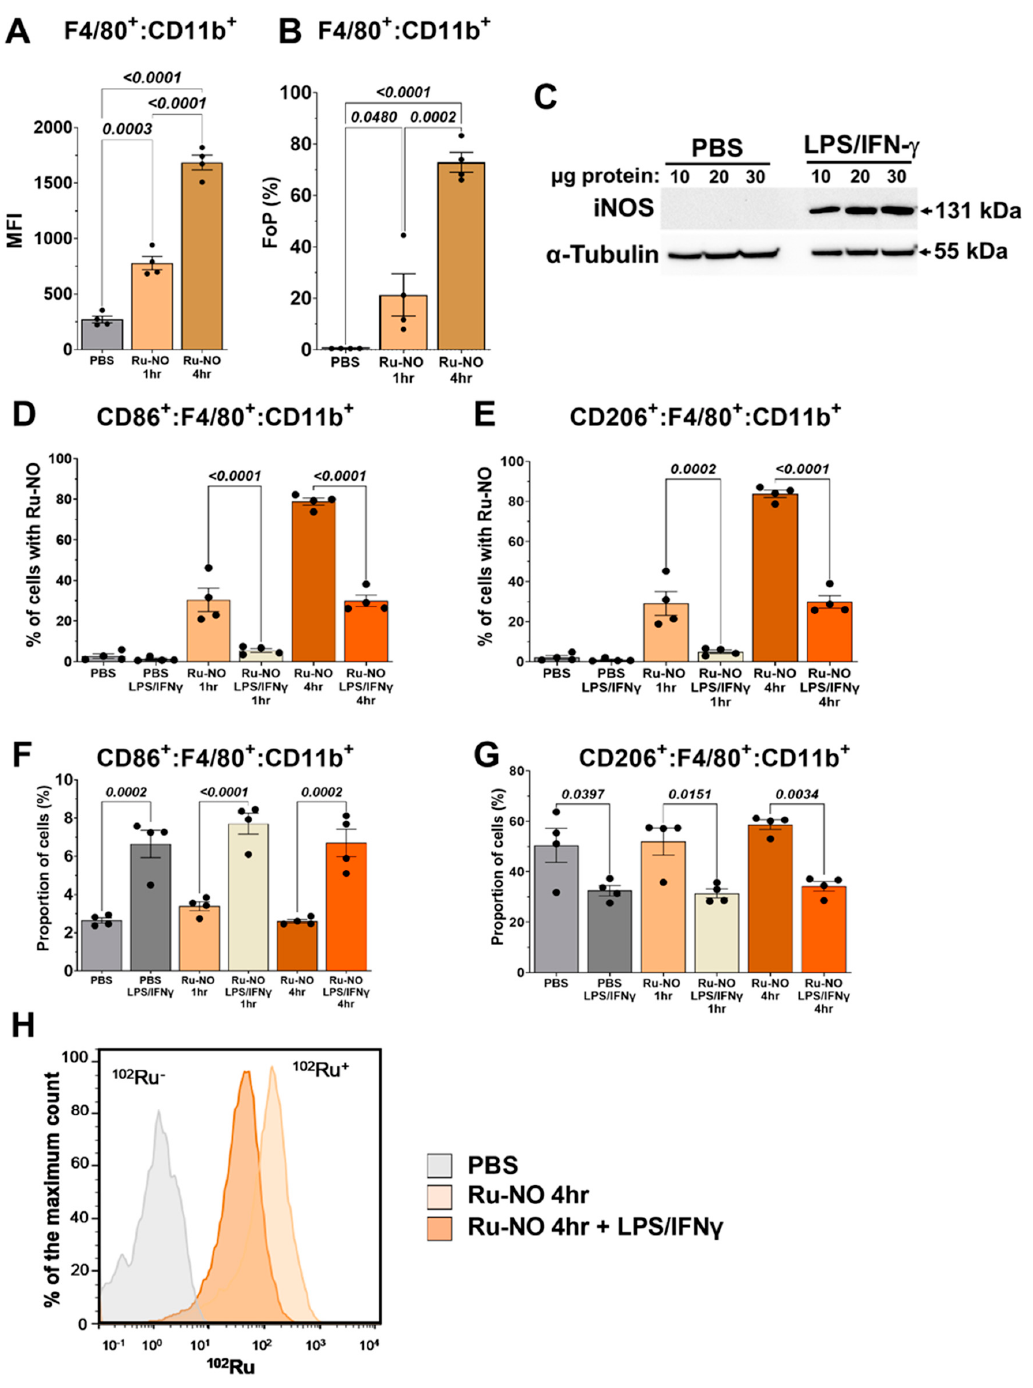
Figure 2. Ru-NO sensor uptake and detection in murine M1- and M2-like macrophages. Mouse bone marrow derived macrophages (BMDMs) were assessed for Ru-NO uptake using flowcytometry. ( A ) Mean Fluorescence Intensity (MFI) and ( B ) Frequency of Parental (FoP) of PBS and Ru-NO ex- posed CD11b + F4/80 + BMDMs in the absence of inflammation/polarisation. ( C ) Western Blot analysis of iNOS expression in BMDMs with/without LPS + IFN- γ stimulation. The percentage of cells with Ru-NO uptake in ( D ) M1-like and ( E ) M2-like macrophages with/without LPS + IFN- γ . The propor- tion of ( F ) M1-like (CD86 + ) and ( G ) M2-like (CD206 + ) macrophages with/without LPS + IFN- γ stim- ulation. ( H ) Mass cytometry histogram for Ruthenium uptake in BMDM with/without LPS + IFN- γ stimulation. Mean ± SEM, p values derived from a one-way ANOVA with Tukey post-hoc test (n = 3, performed in quadruplicate) repeated